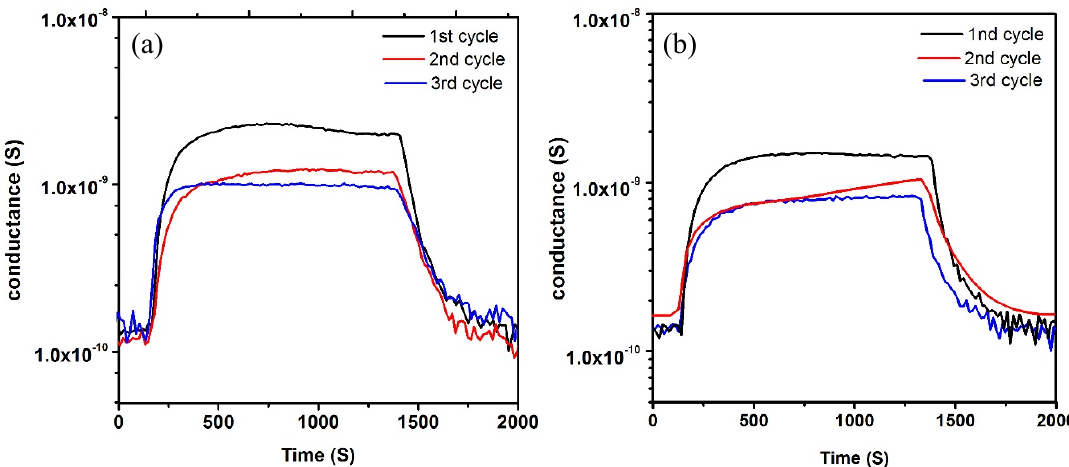
Figure 9. The repeatability of TiO 2 NWs sensors at 400 °C exposed to ( a ) ethanol (500 ppm) ( b ) hydrogen (500 ppm). RH = 40%, with an applied voltage equal to 1 V.